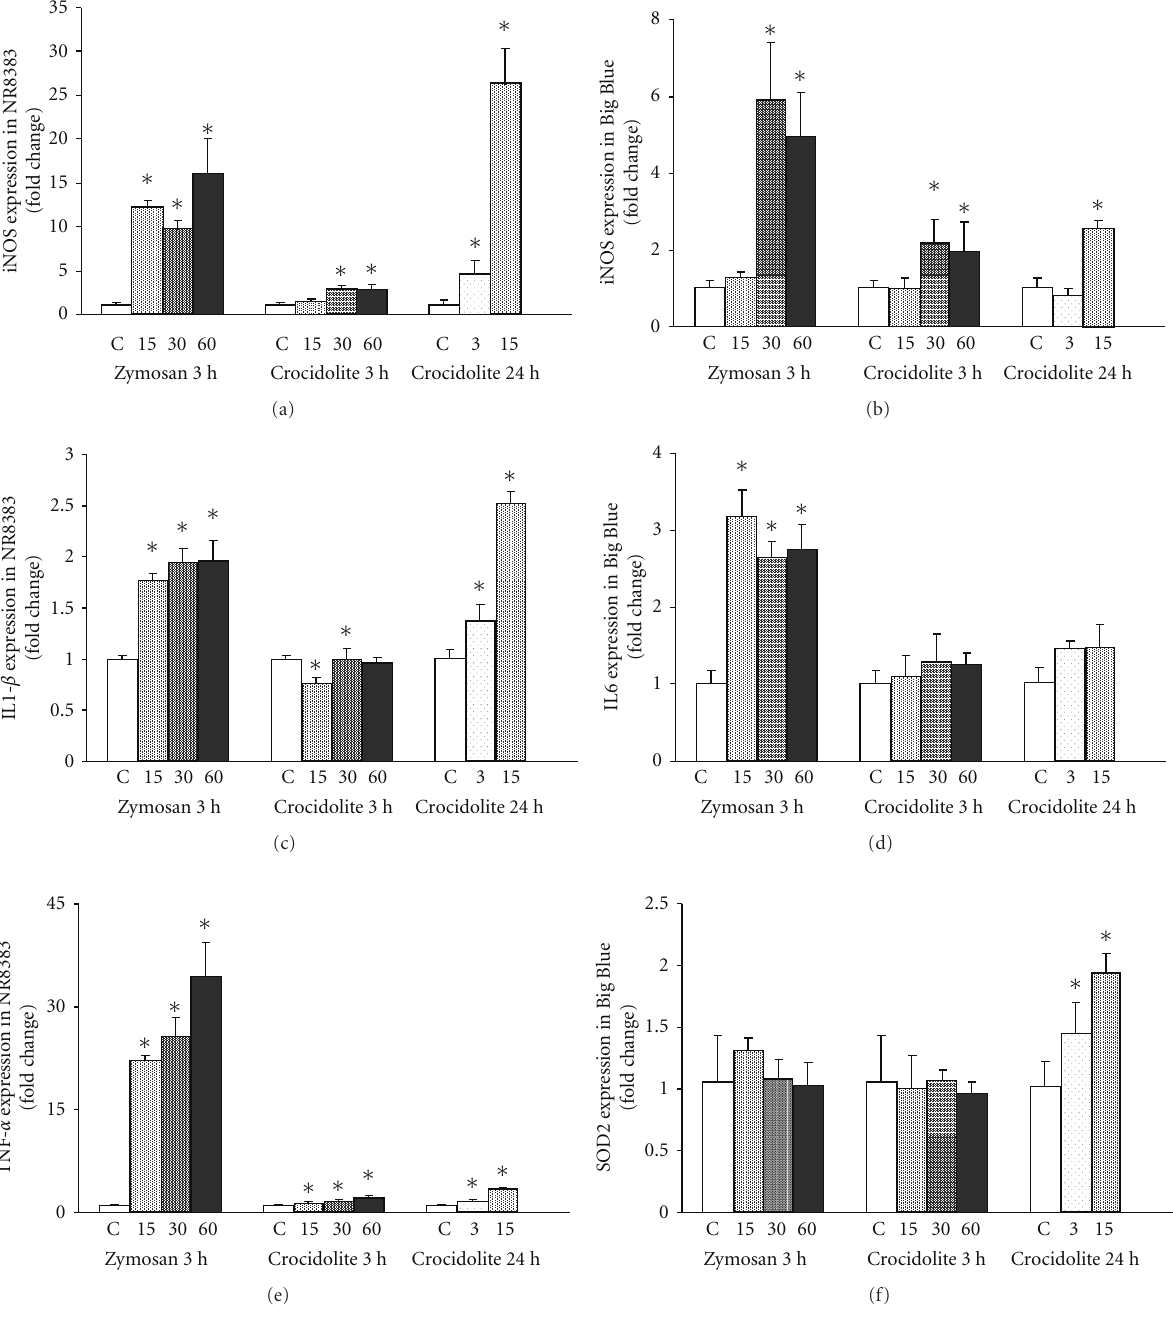
Figure 3: E ff ect of treatment with crocidolite and zymosan for 3 hours (15, 30, and 60 μ g/cm 2 ) or with crocidolite for 24 hours (3 and 15 μ g/cm 2 ) on the expression of various genes in NR8383-Big Blue separated cocultures. Levels of iNOS, IL1 β , and TNF α mRNA in NR8383 and levels of iNOS, IL-6, and SOD-2 mRNA in Big Blue were assessed by qPCR, using β -actin as an endogenous external standard. Data are expressed as “fold change” of the control value (see materials and methods). Results represent the mean ± SD of at least 3 experiments. ∗ Statistically significant ( P < . 05) increase in gene expression compared to the control (unexposed) cocultures.